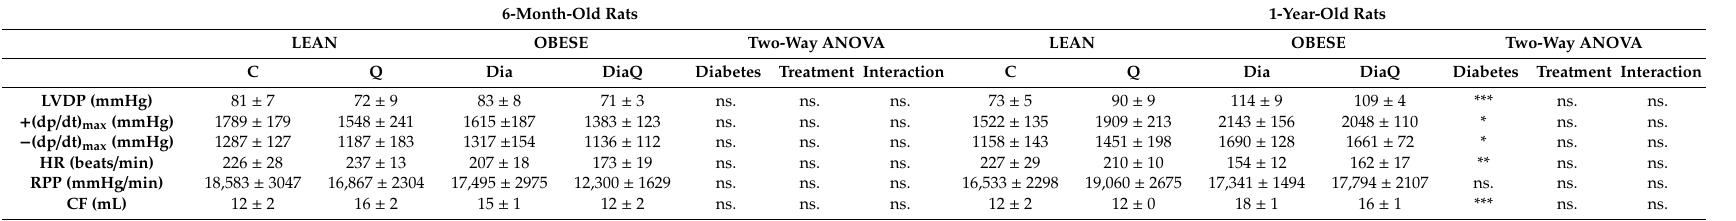
Table 2. Pre-ischemic (baseline) values of functional parameters of isolated